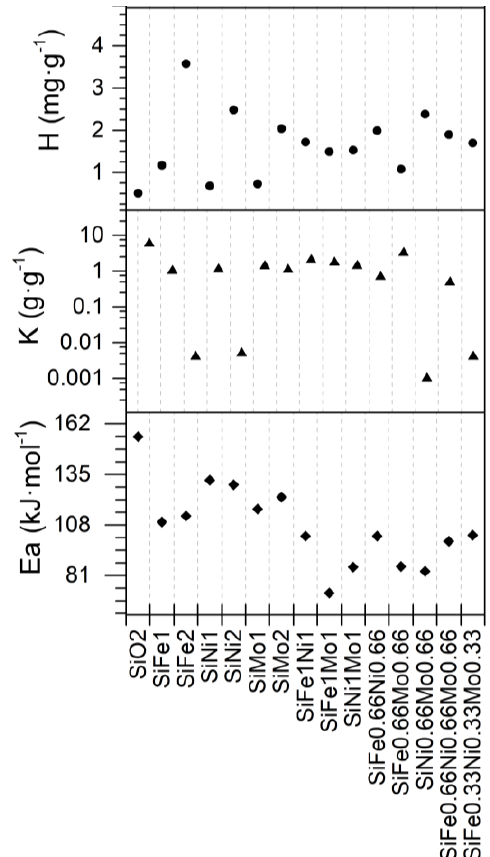
Figure 5. Estimated SLE model parameters and effective activation energy values for SiO 2 and functionalized nanoparticles.